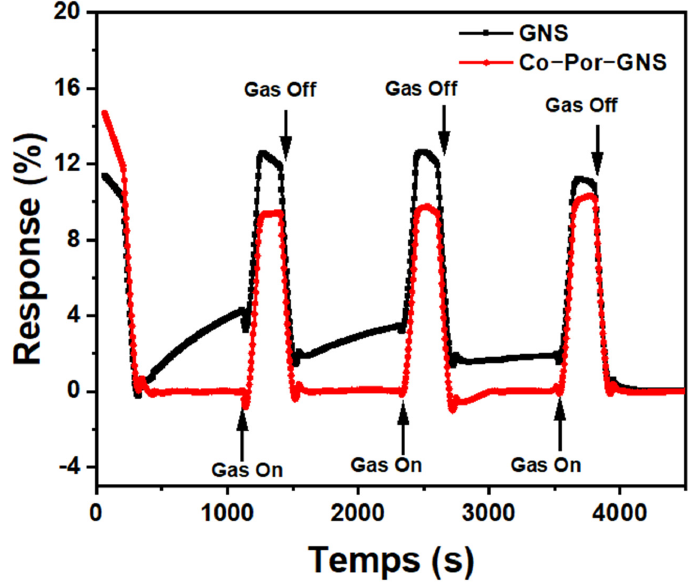
Figure 10. The repeatability properties of the GNSs and functionalized GNSs with Co-Por sensor exposed to 1 ppm NO 2 .